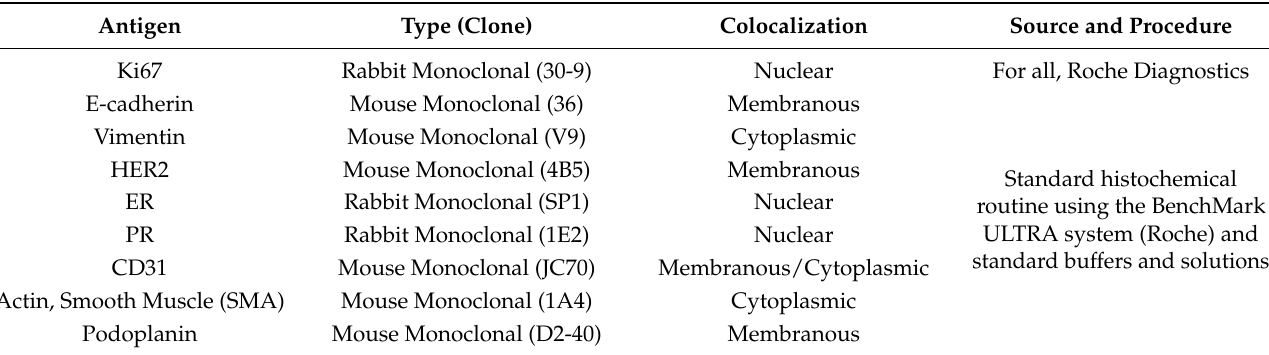
Table 4. Diagnostic primary antibodies used in the